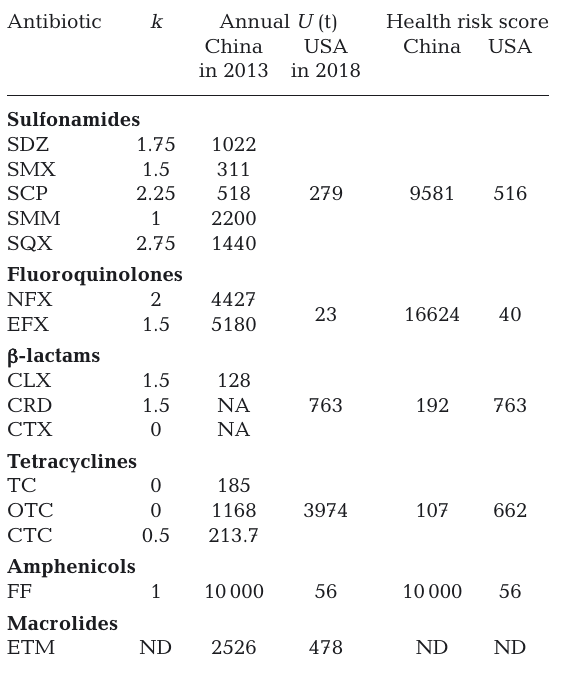
Table 3. Comprehensive scores of health risk for various cat- egories of antibiotics based on their endocrine-disrupting potential coefficient (k) and annual usage (U) in aquacul- ture. Data for U is from food-producing animals (China: Zhang et al. 2015; USA: USFDA 2019), since no data was available for aquaculture. For China, for each antibiotic cat- egory, the comprehensive score of health risk is equal to: ∑ n i=1 [Endocrine-disrupting potential coefficient (k i )] × annual us- age (U i ). For the USA, no antibiotic-specific U data was avail- able, thus the average of k for each antibiotic for each cate- gory was multiplied by total U to get the comprehensive score of health risk: ∑ n i=1 [Endocrine-disrupting potential coef- ficient (k i )] / n × total annual usage (U total ). n: number of an- tibiotics included in a category; NA: not available; ND: not determined since relative molecular weight exceeds 500. Antibiotic abbreviations as in Table